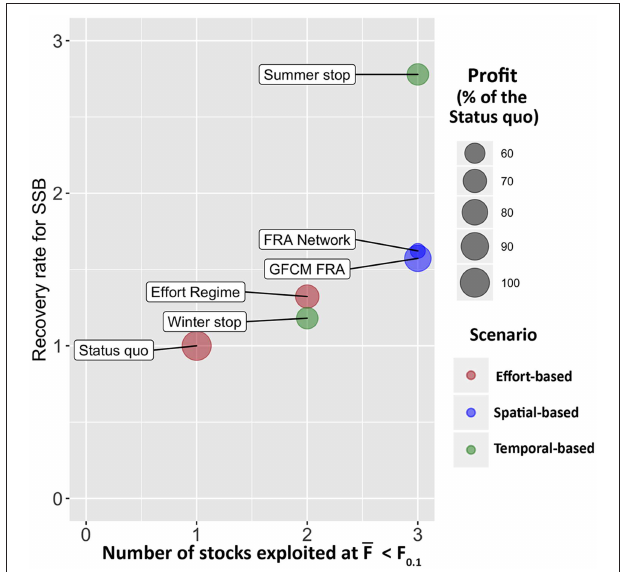
FIGURE 11 | Management Strategy Evaluation of the different scenarios. The x axis corresponds to the number of stocks that are expected to be exploited at F 0.1 after the implementation of the corresponding scenario, the y axis corresponds to the mean recovery rate for SSB of the four stocks, computed SSB Scenario 2017 − 2022 . The size of the bubble represents the percentage of profit as SSB Status quo 2017 − 2022 with respect to the status quo , for each scenario, in the first year (2017) of application. The color of the bubble groups the scenarios by